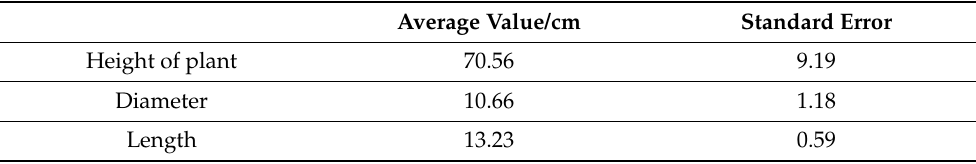
Table 1. Pineapple physical